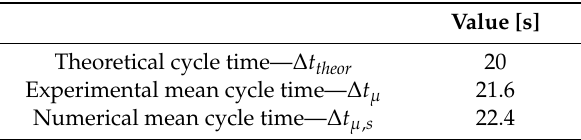
Table 4. Mean working times in several steps of the